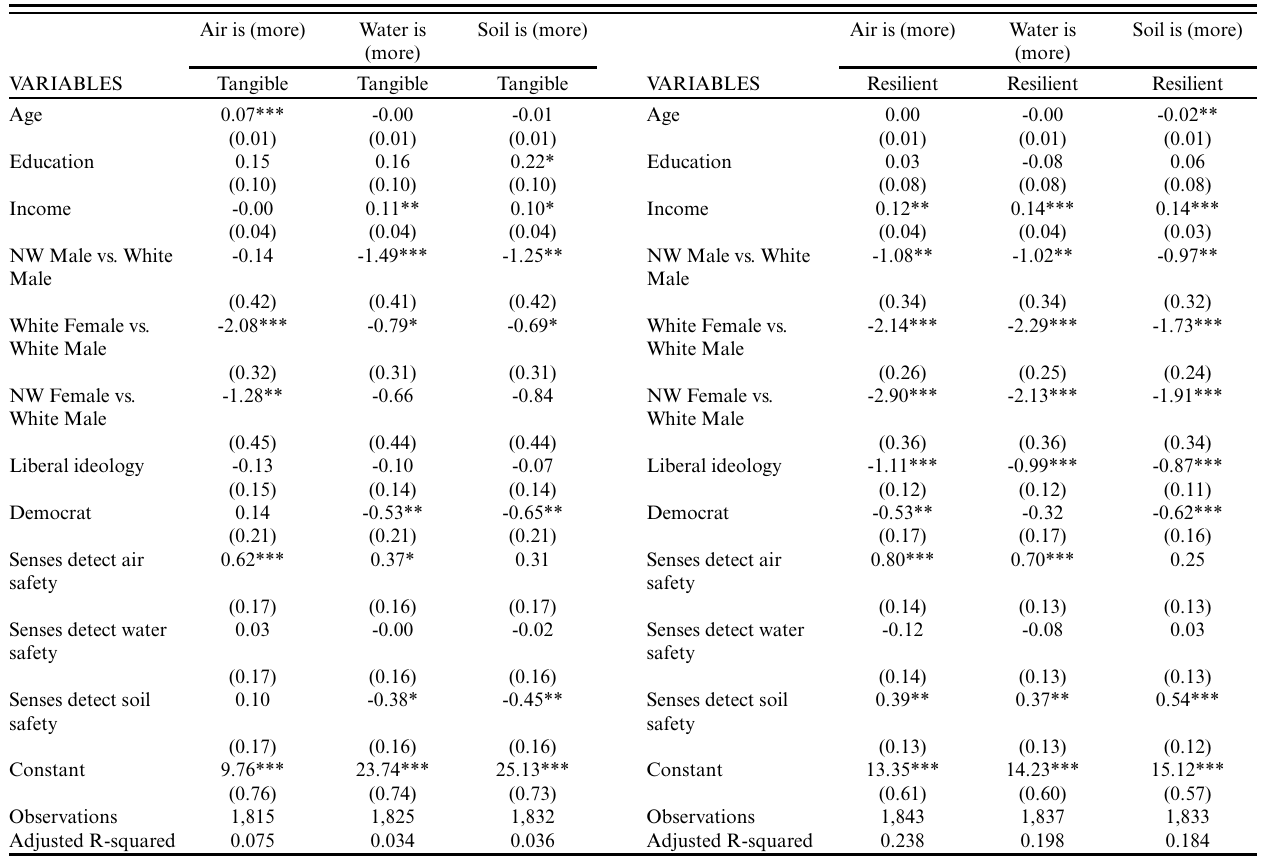
Table 6 . Pattern matrix for ordinary least squares (OLS) findings. Perceived tangibility and resilience x belief in ability of senses to detect harm. Three estimated OLS regressions for the perceived tangibility of air, water, and soil, and 3 OLS regressions for the perceived resilience of air, water, and soil, using the main independent variables: “senses help detect [air, water, and soil] safety.” Control variables included age, education, income, nonwhite males (vs. white males), white females (vs. white males), and nonwhite females (vs. white